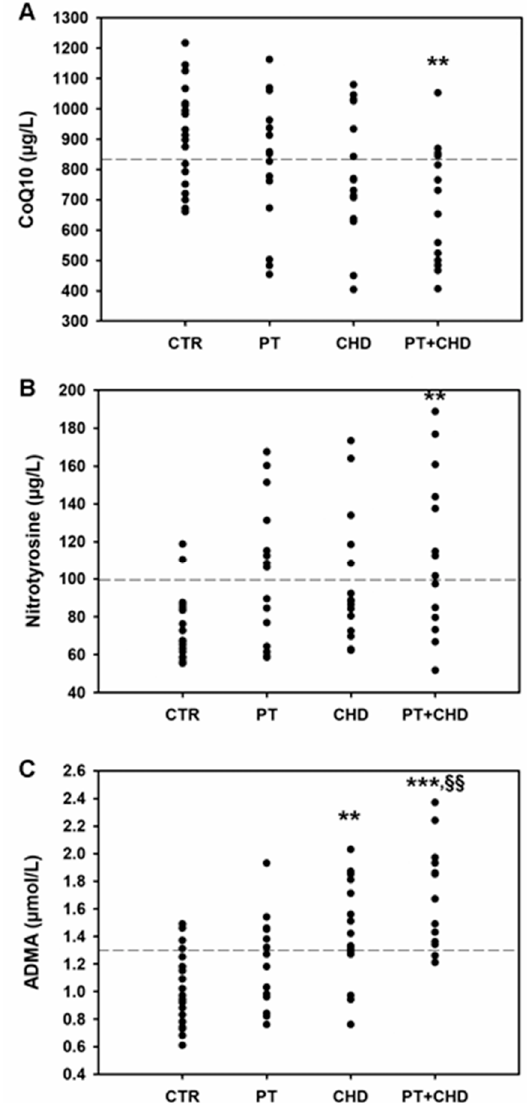
Figure 1. Values of CoQ10 ( A ), NT ( B ) and ADMA ( C ) in patients and control subjects. ** p < 0.01 and *** p < 0.001 significant differences vs control subjects; §§ p < 0.01 significant difference vs PT patients. Dotted lines indicate the limit of reference values.